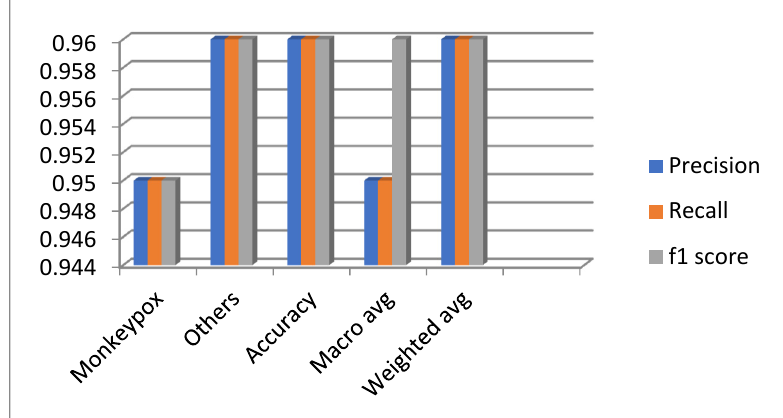
Figure 16. overall performance evaluation of the diseases. Figure 16. Overall performance evaluation of the Figure 17 represents the confusion matrix for the monkeypox disease detection; the values are generated based on the true positive, true negative, false positive, and false negative. Here most of the classes are recognized correctly and performs be tt er.